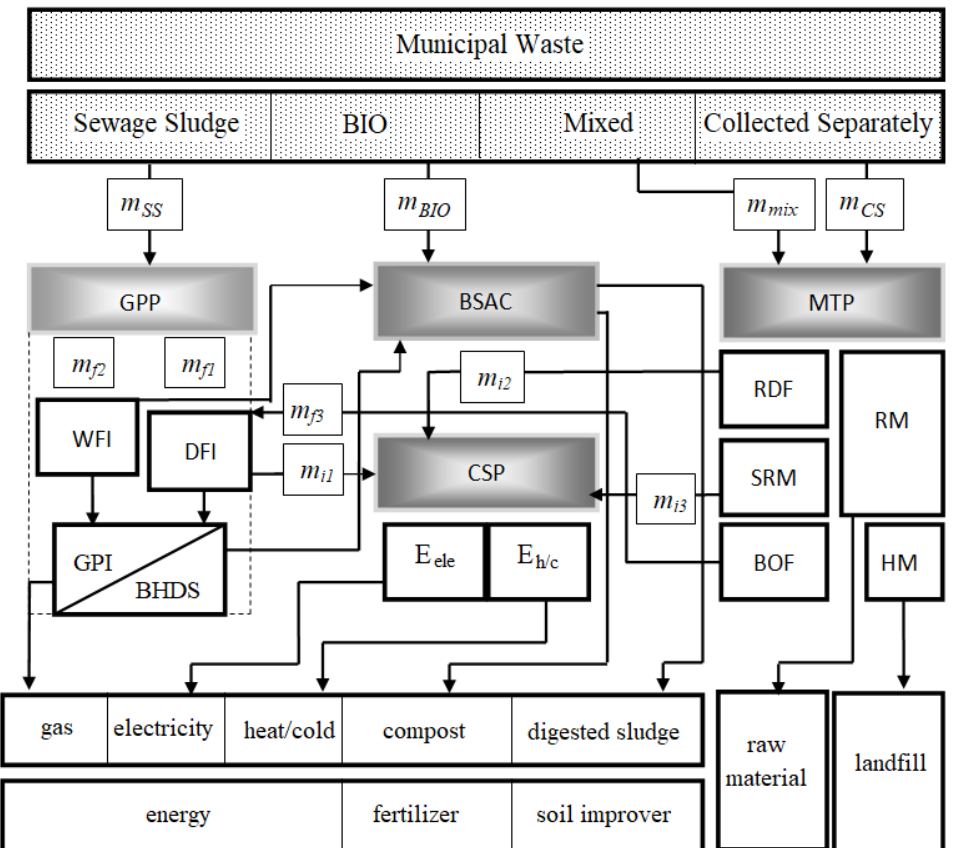
Figure 1. Block diagram of the ERWP model.